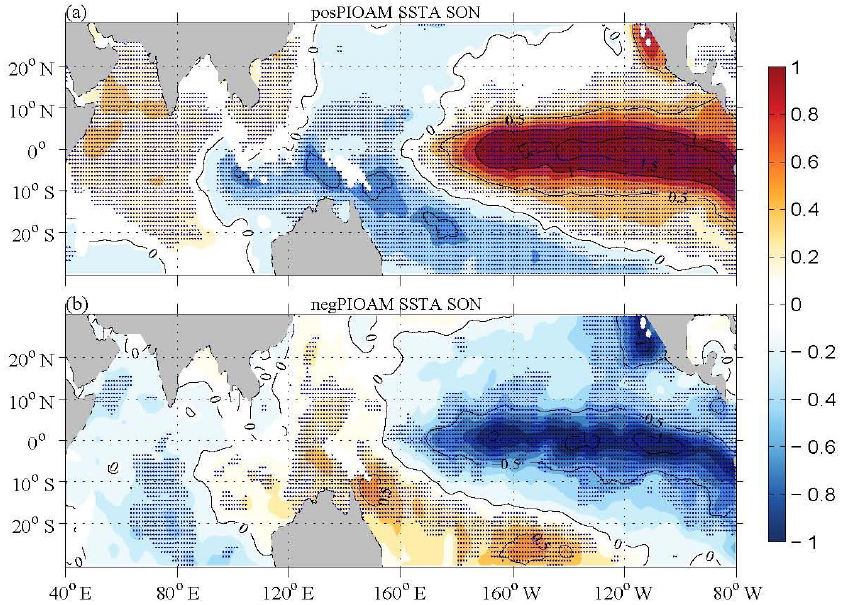
Figure 11. Composite sea surface temperature anomalies (SSTA) ( ◦ C) in autumn during the ( a ) positive and ( b ) negative phases of PIOAM.